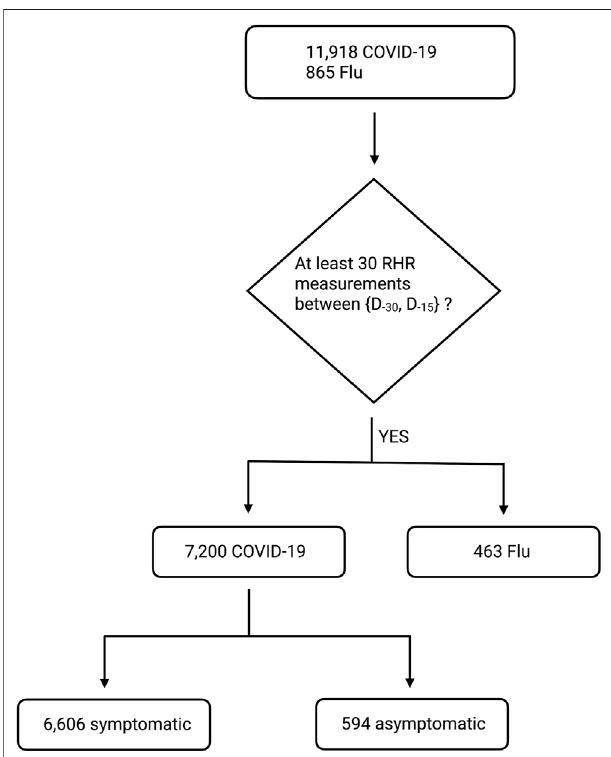
FIGURE 2 | Block diagram showing the number of survey participants with COVID-19 or fl u. We start with all participants with diagnosed COVID-19 between{2020-03-01, 2020-12-31},or diagnosed fl u between {2020-01-01, 2020-12-31}. Note that D 0 is the date of symptom onset for symptomatic individuals (and the test date for asymptomatic individuals). We thendiscardindividualswithfewerthan30RHRmeasurementsbetween D − 90 and D − 15 . Our fi nal dataset contains 463 individuals with fl u, 6,606 individuals with symptomatic COVID-19, and 594 individuals with asymptomatic